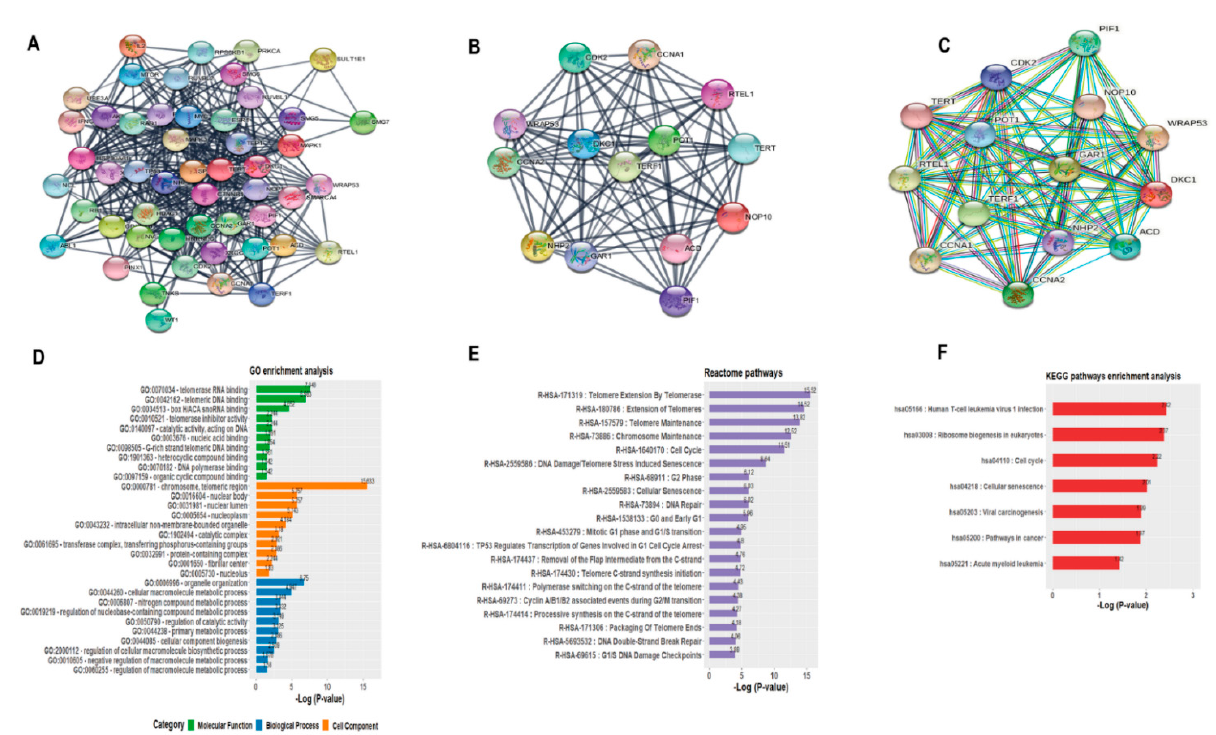
Figure 5. Protein–protein interaction network for hTERT . ( A ) Prototype of the PPI network built with Cytoscape containing 51 nodes and 377 edges. ( B ) PPI generated with MCODE presented a score of 13.53 with 14 nodes and 88 edges. ( C ) Validation done with String-db for the PPI topology containing 14 gene hubs that was predicted by the MCODE algorithm. ( D ) GO functional annotation for PPI genes. ( E ) Identification of enzymatic reaction pathways of REACTOME and ( F ) Pathways of KEGG. All annotation terms were normalized with Log10 ( p -value). PPI: Protein–Protein Interaction.